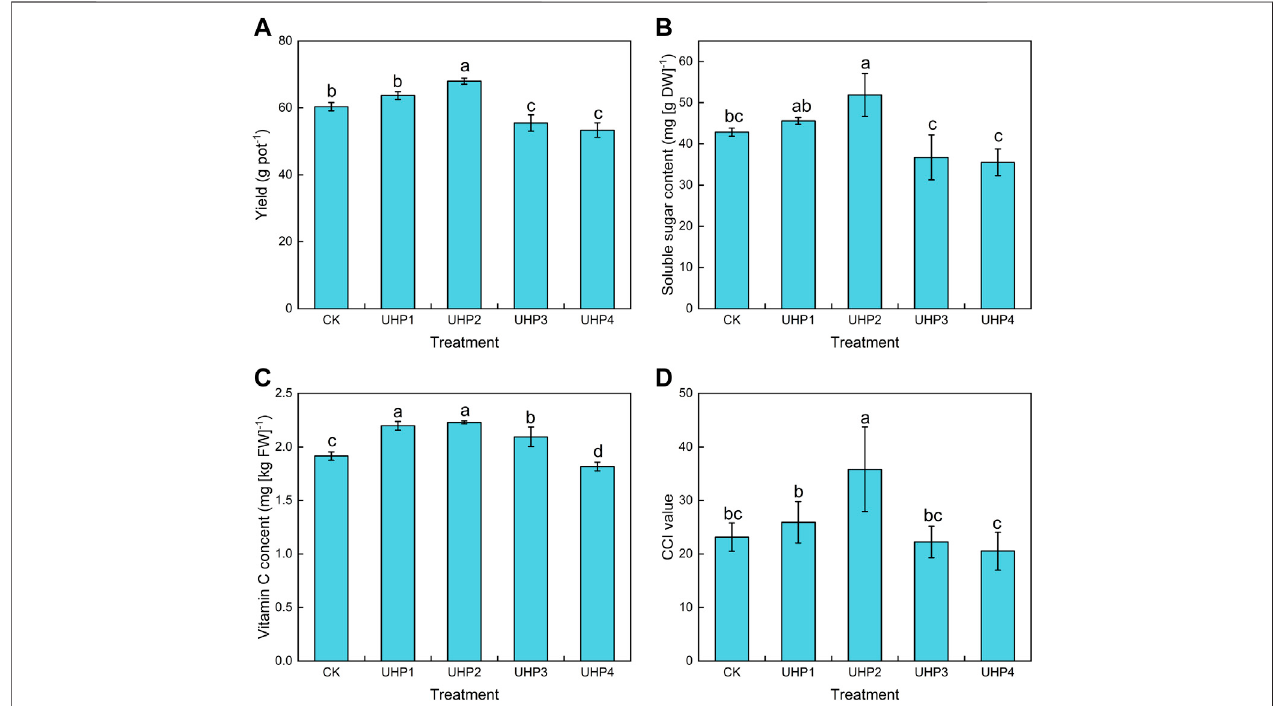
FIGURE 4 | Effects of aeration on amaranth yield and quality at harvest. (A) Yield, (B) soluble sugar content, (C) ascorbic acid (vitamin C) content, and (D) chlorophyll content index (CCI). Bars indicate mean ± SD. Different letters on the bars indicate a signi fi cant difference between different treatments.